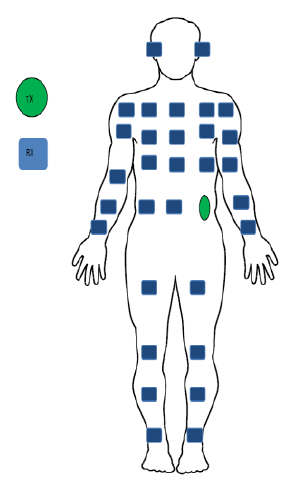
Figure 8. The transmitter antenna is on left waist and the receiver antenna is attached to 31 different locations on the body for on-body radio propagation measurement at 2.45